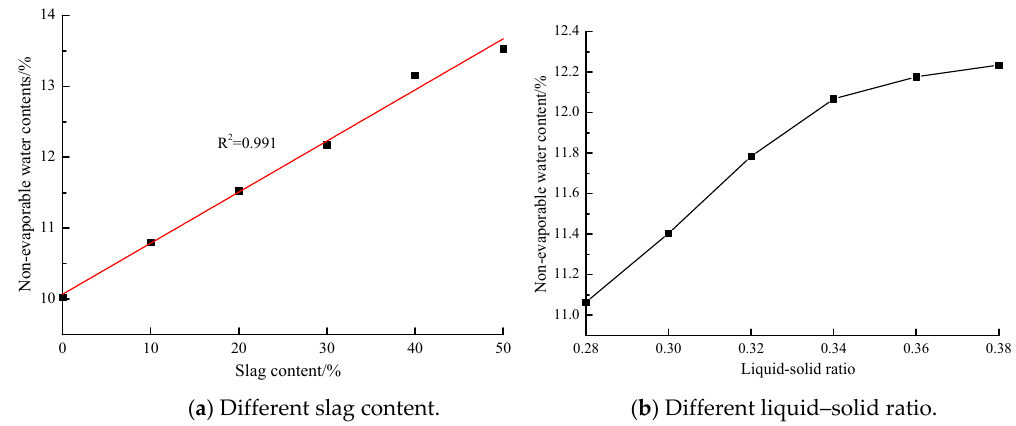
Figure 4. The non-evaporable water dosages of AACGS samples. ( a ) Different slag content; ( b ) Different liquid–solid ratio.